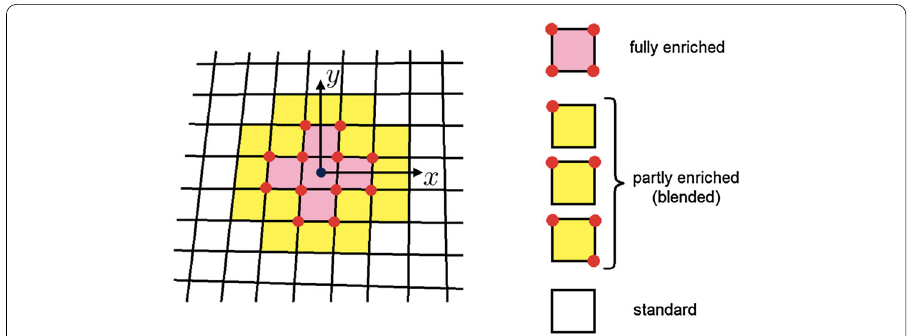
Fig. 7 Types of elements in mesh P h with respect to the imposed